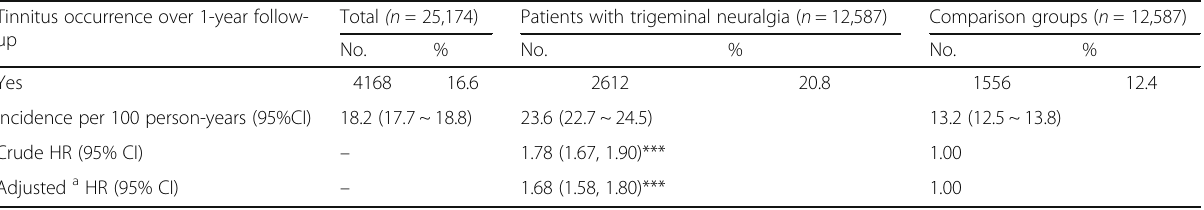
Table 2 Incidence rate, crude and adjusted hazard ratios for tinnitus among the sampled patients Tinnitus occurrence over 1-year follow- up